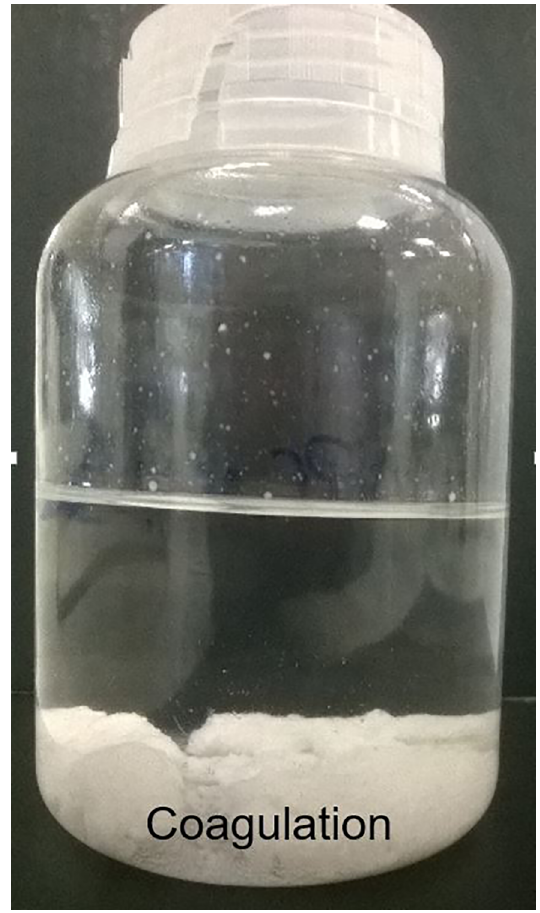
Figure 4. Polymer coagulation of Batch